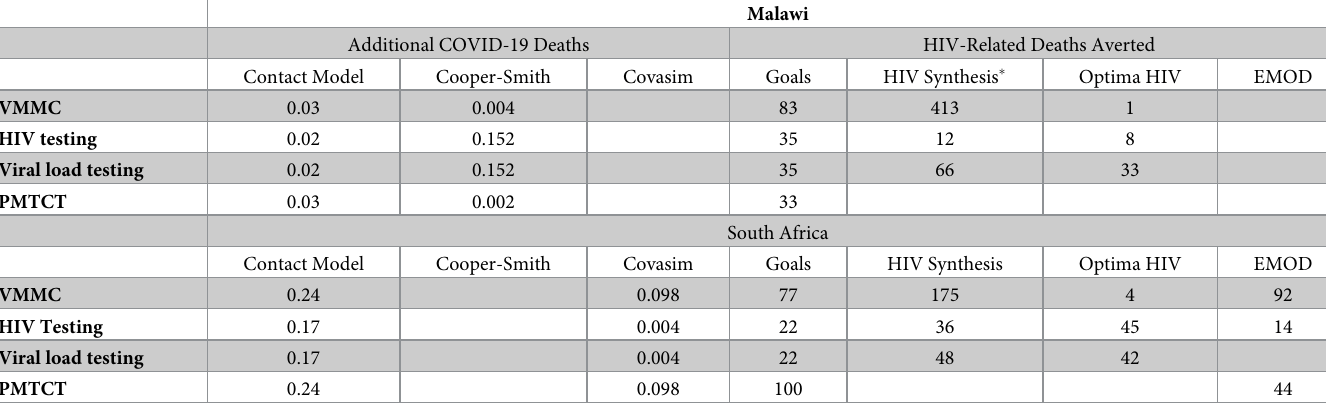
Table 4. Results for Malawi and South Africa per 10,000